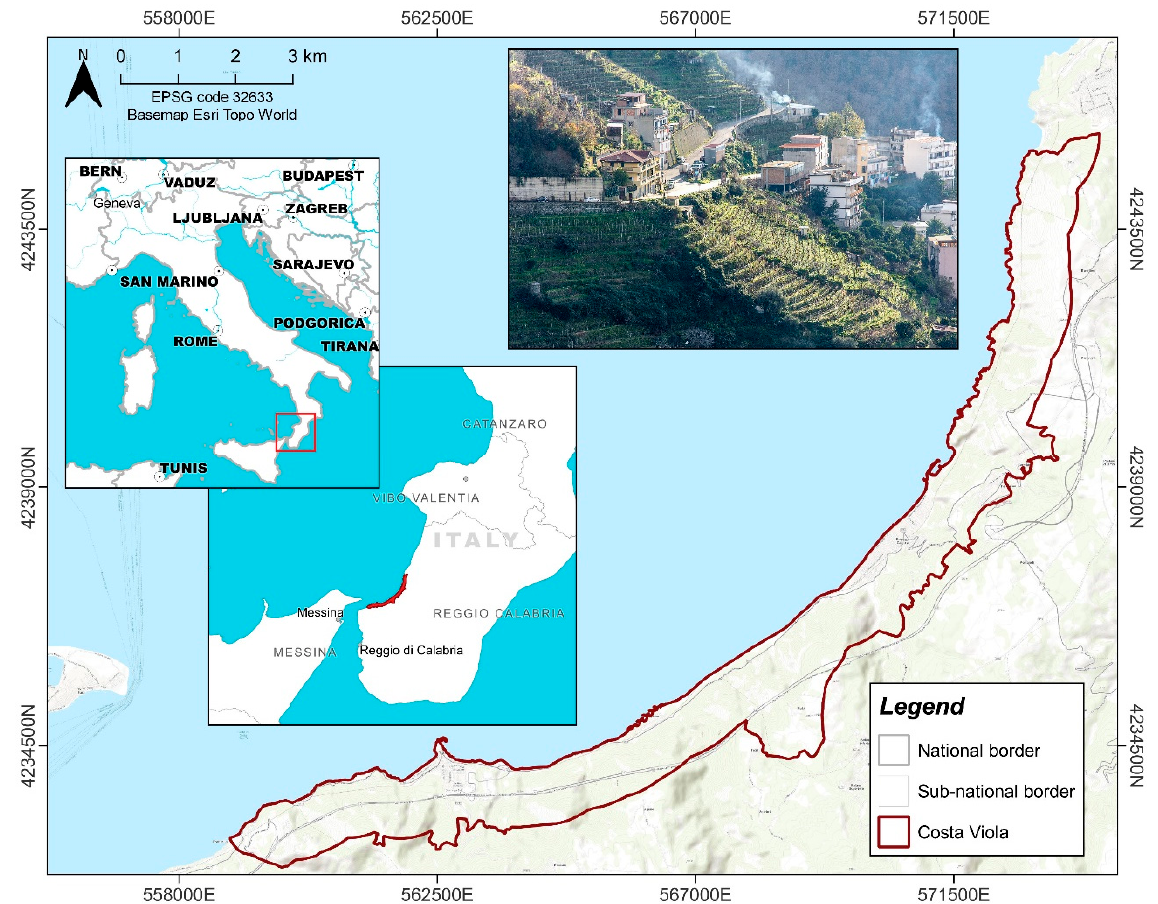
Figure 2. Geolocalization of the study area, the Costa Viola landscape.